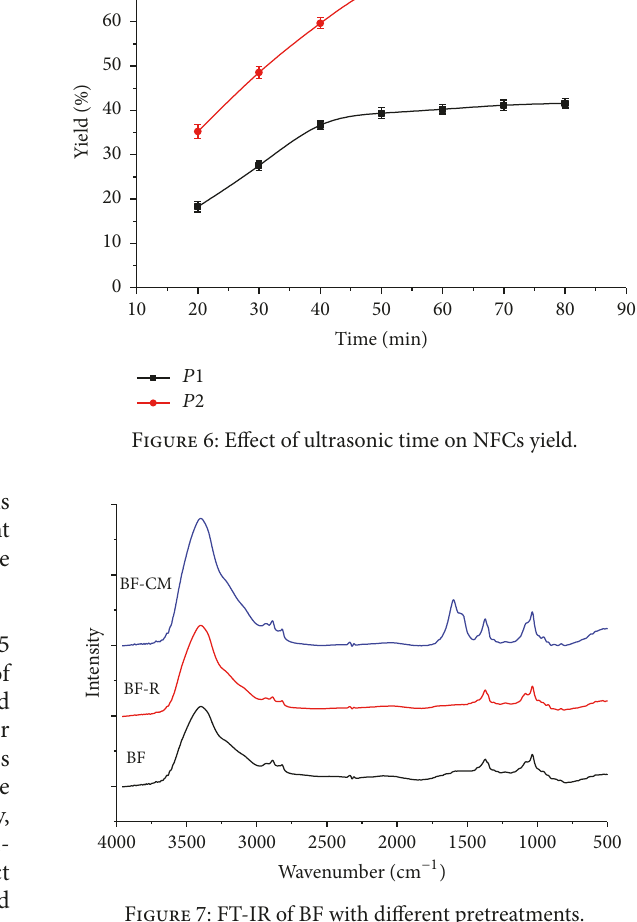
Figure 7: FT-IR of BF with different